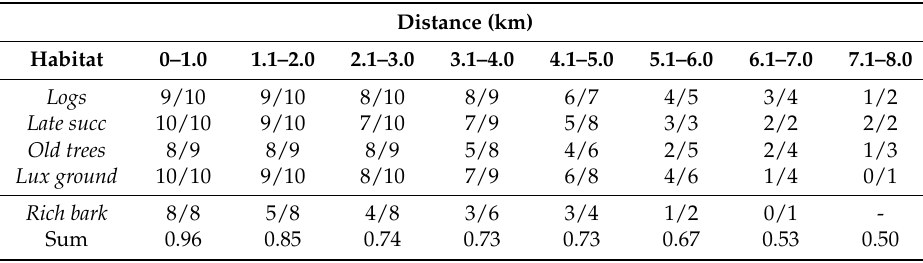
Table 3. Clustering of the most common habitats at different spatial scales, expressed as the proportion of investigated municipalities where the habitat units appeared more clustered than random according to a Ripley K analysis (see the Appendix). The sum row shows calculated proportion when adding clustered outcomes for all habitats and dividing by the total number of outcomes. Late succ = Late succession of deciduous trees , Lux ground = Luxuriant ground vegetation , Rich bark = Trees with nutrient-rich bark